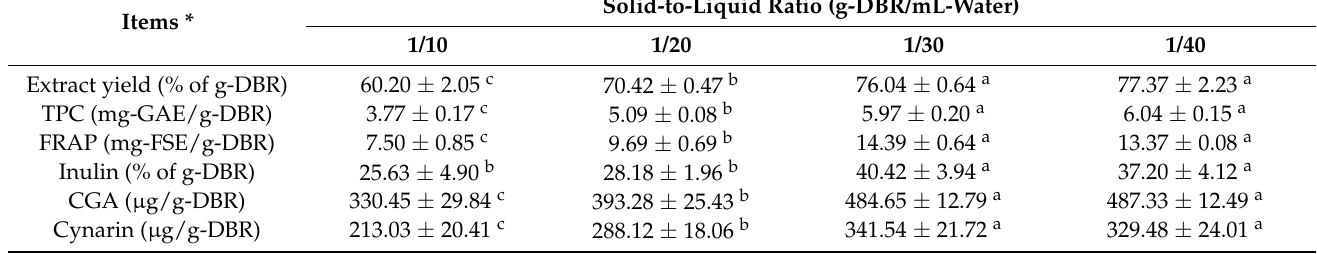
Table 2. Effect of solid-to-liquid ratio on extract yield, total phenolic content (TPC), ferric-reducing antioxidant power (FRAP), inulin, chlorogenic acid (CGA), and cynarin in dried burdock root powder